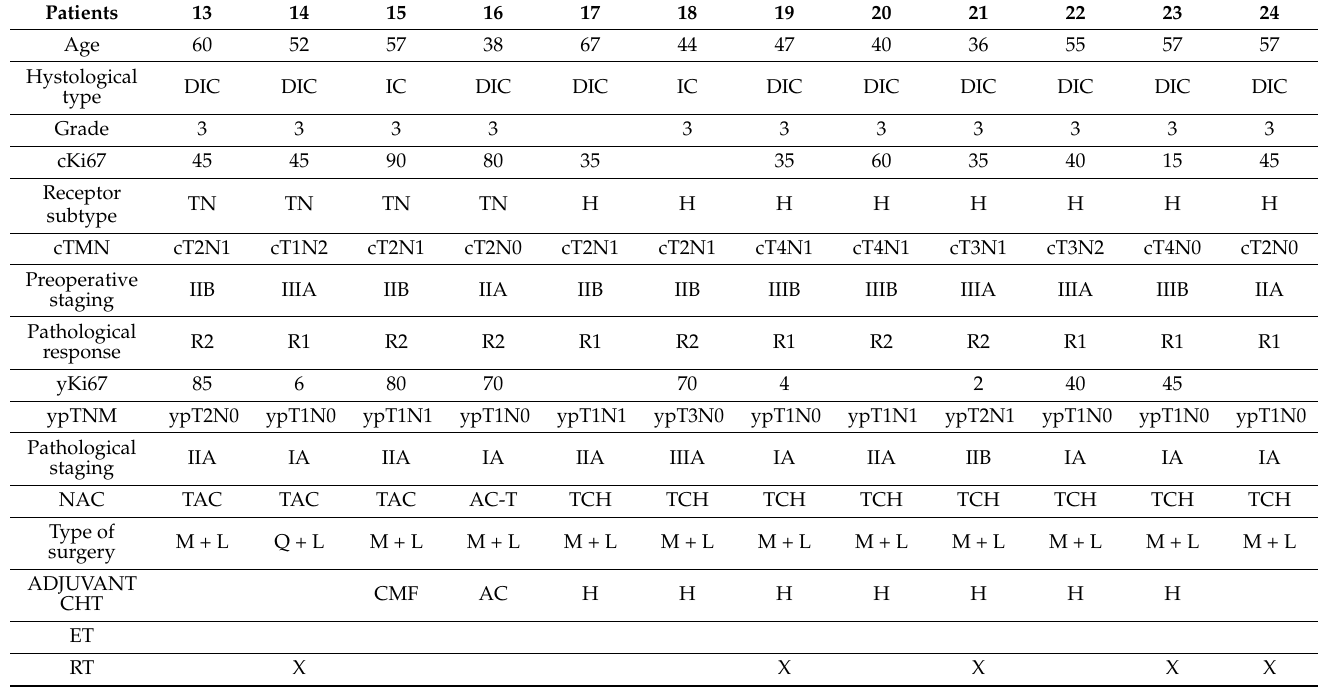
Table 3. Clinicopathological characteristics of breast cancer selected patients (N